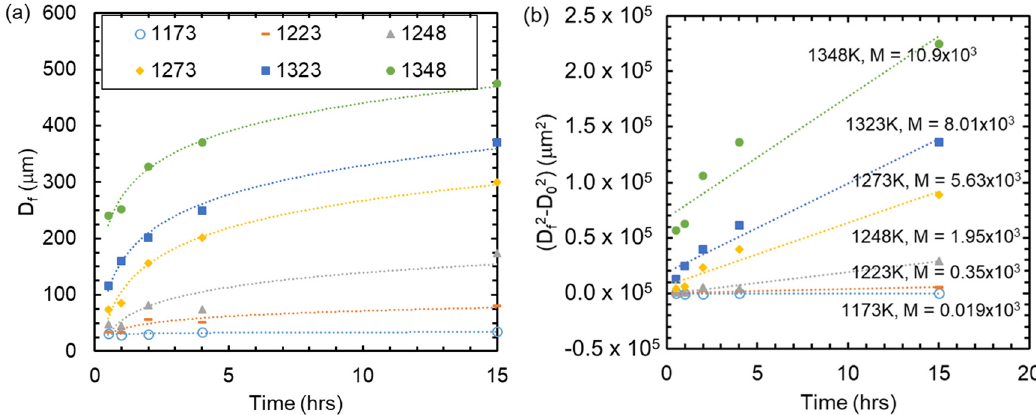
Figure 2. ( a ) γ -austenite grain size as a function of annealing time and temperature illustrating parabolic response. ( b ) Mobility calculation to obtain the growth rate as a function of annealing time according to equation 1.